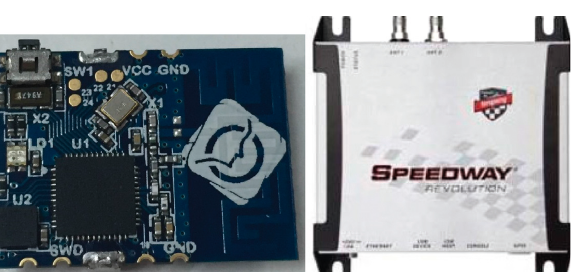
Figure 19: Bluetooth and RFID test devices.